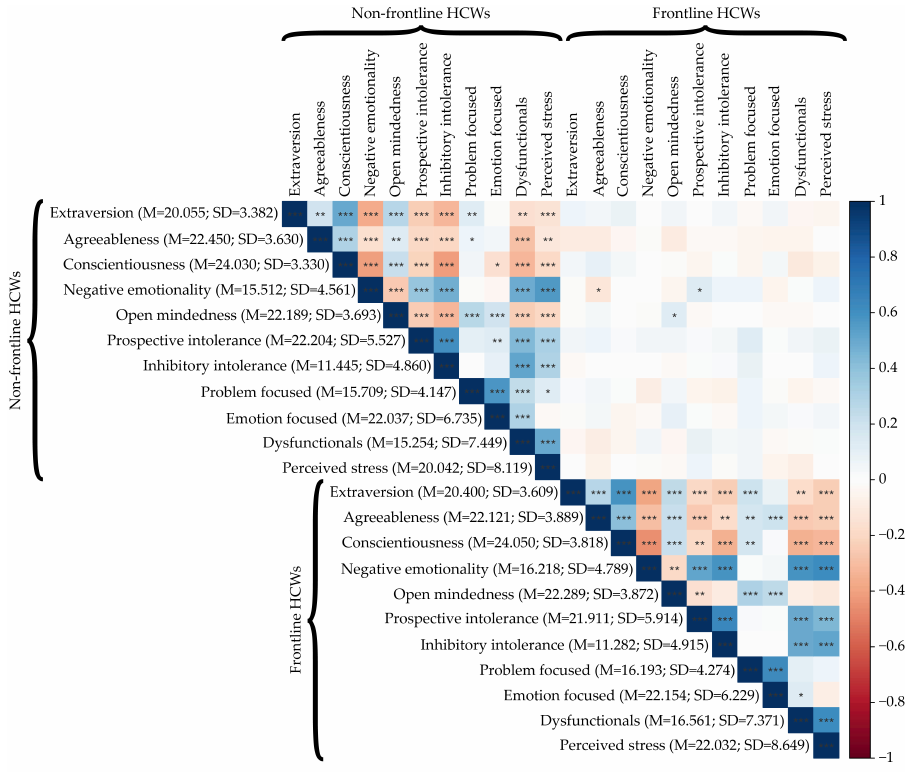
Figure 4. Pearson’s Correlations and descriptive statistics of the experimental variables (* p < 0.05, ** p < 0.01, *** p < 0.001).